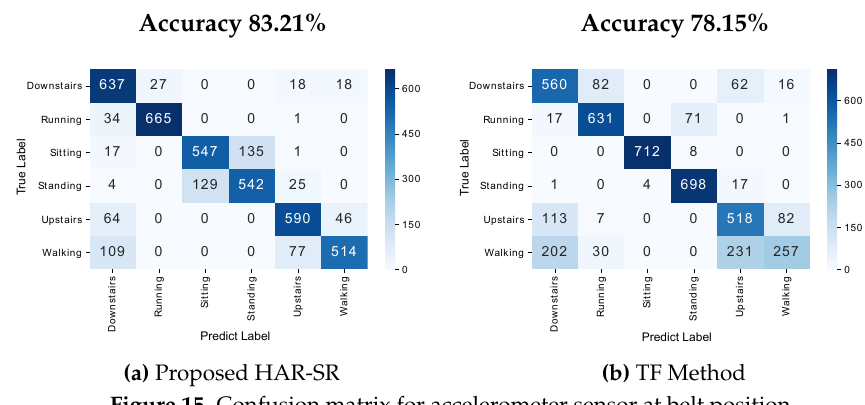
Figure 15. Confusion matrix for accelerometer sensor at belt